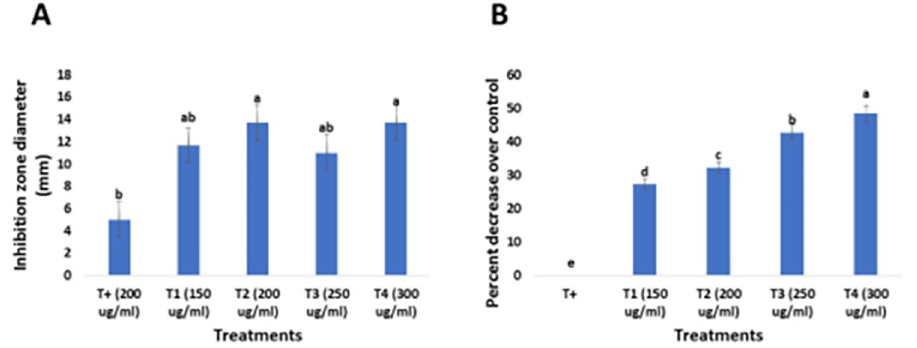
Fig 11. Antifungal activity of green synthesized SeNPs against Fusarium mangifera . (a) Well diffusion method (b) Radial growth method. Data are expressed as means ± standard deviations of triplicate assays. The different alphabetic superscripts in the same column are significantly different (p < 0.05) based on Duncan’s multiple comparison test.